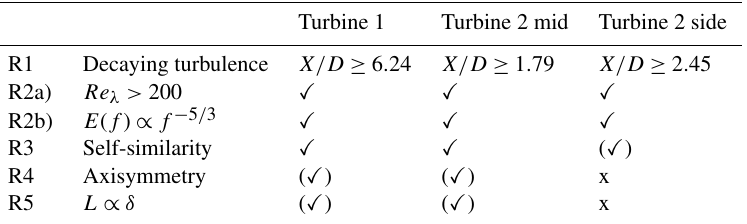
Table 1. Summary of the investigation of which requirements are fulfilled at the centerline in the three wake scenarios: (cid:88) denotes the fulfillment of a criterion; ( (cid:88) ) denotes the sufficient fulfillment of a criterion; and x denotes that the criterion is not